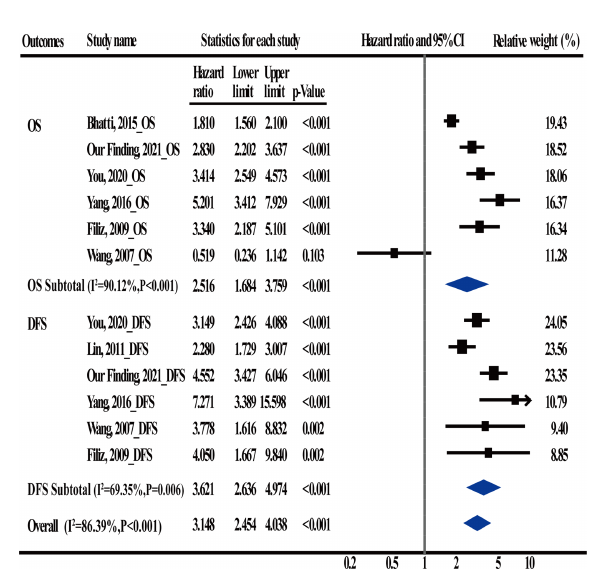
FIGURE 4 | Meta-Analysis estimate postoperative carcinoembryonic antigen (CEA) levels serves as an independent prognostic factor in CRC patients.